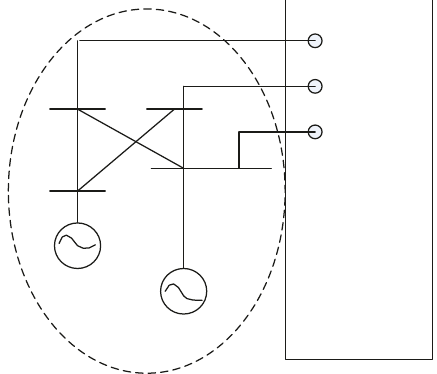
Figure 3: A simplified cluster of nodes with reactive power source